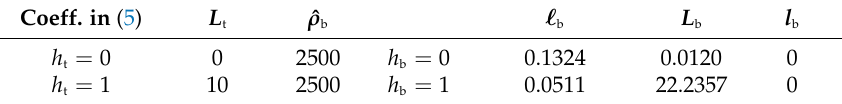
Table 2. Homogenized coefficients entering in the effective conditions (3) in (5).